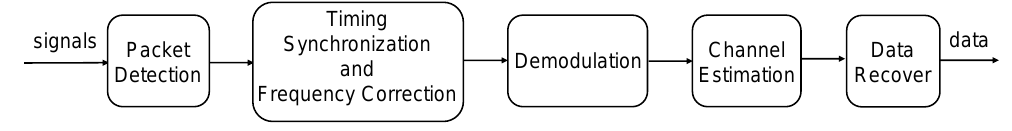
Figure 2. WiFi receiver processing.